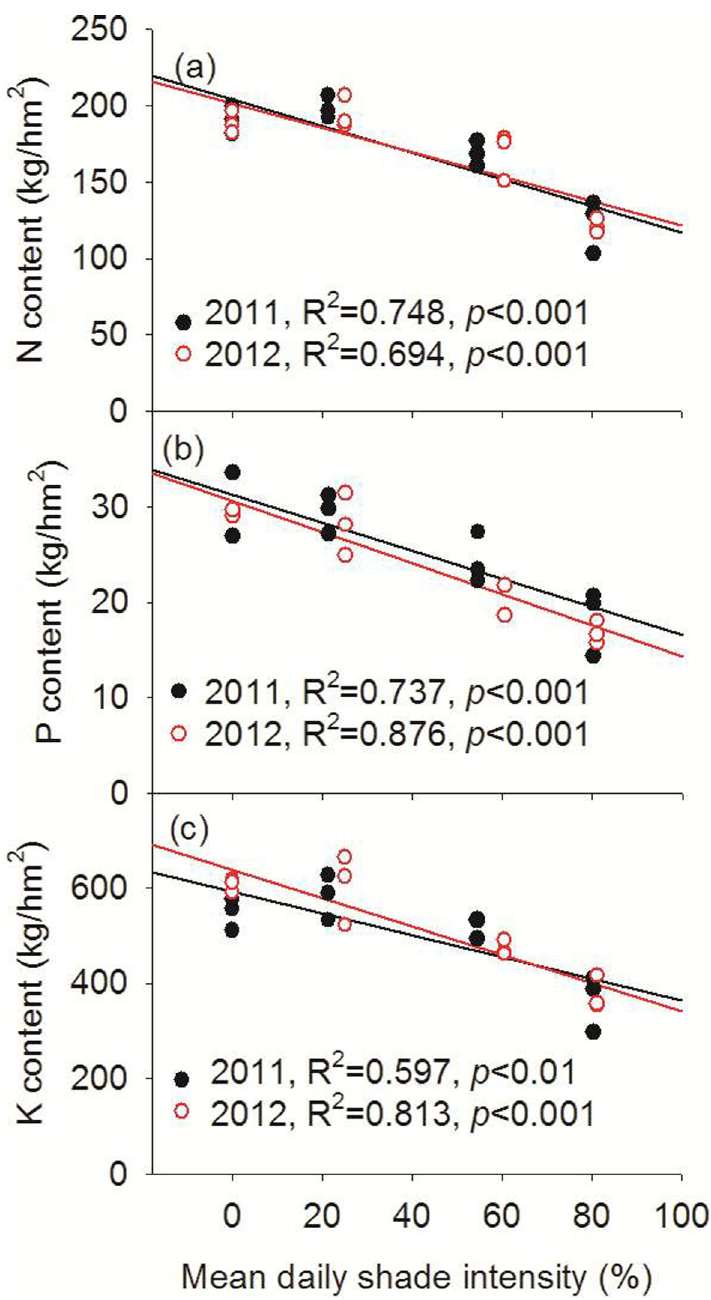
Fig 6. Relationship between the N, P and K contents with mean daily shade intensity of wheat in 2011 and 2012.